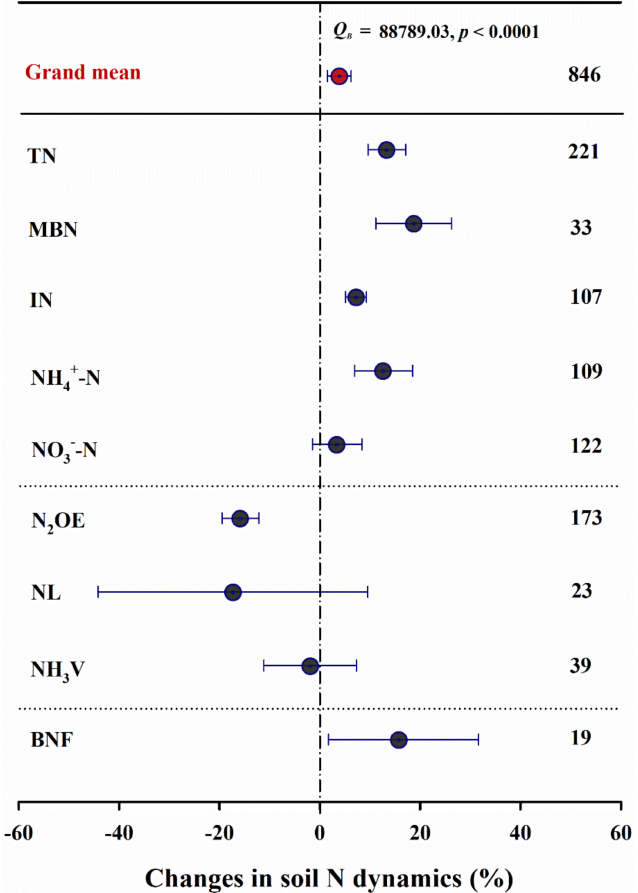
Figure 3. The percentage changes (%) of biochar effects on the parameters of N dynamics including soil total N (TN), microbial biomass N (MBN), inorganic N (IN), ammonium N (NH 4+ -N), nitrate N (NO 3 − -N), N 2 O emission (N 2 OE), N leaching (NL), NH 3 volatilization (NH 3 V), and biological N 2 fixation (BNF). Bars indicate 95% confidence intervals. Data at right side of each panel represent the number of observations.